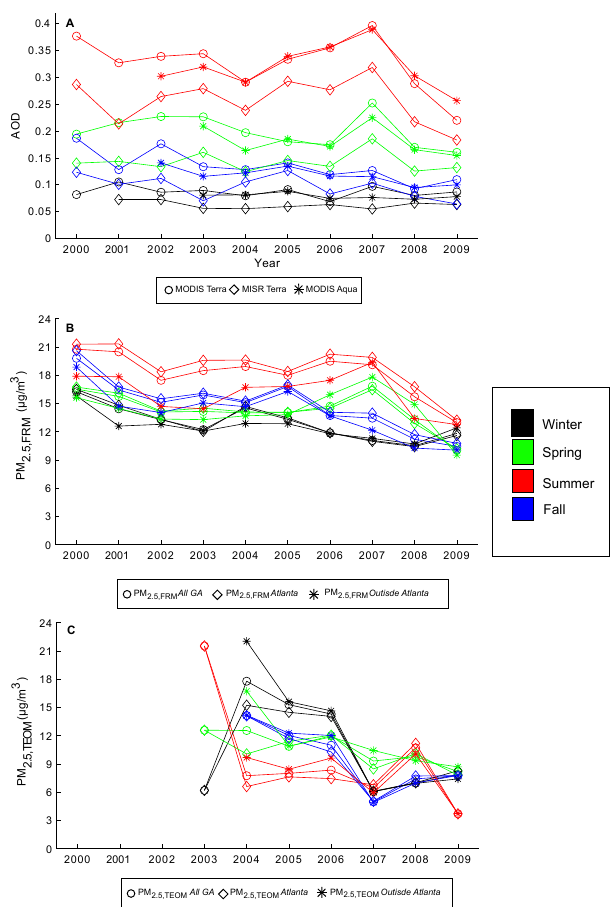
Fig. 5. (A) Time series of seasonal means for MODIS Terra AOD, MISR Terra AOD and MODIS Aqua AOD. (B) Same as (A) except for PM 2 . 5 , FRM AllGA , PM 2 . 5 , FRM Atlanta and PM 2 . 5 , FRM OutsideAtlanta . (C) Same as (A) ex- cept for PM 2 . 5 , TEOM AllGA , PM 2 . 5 , TEOM Atlanta and PM 2 . 5 , TEOM OutsideAtlanta . The units for all PM 2 . 5 are µgm − 3